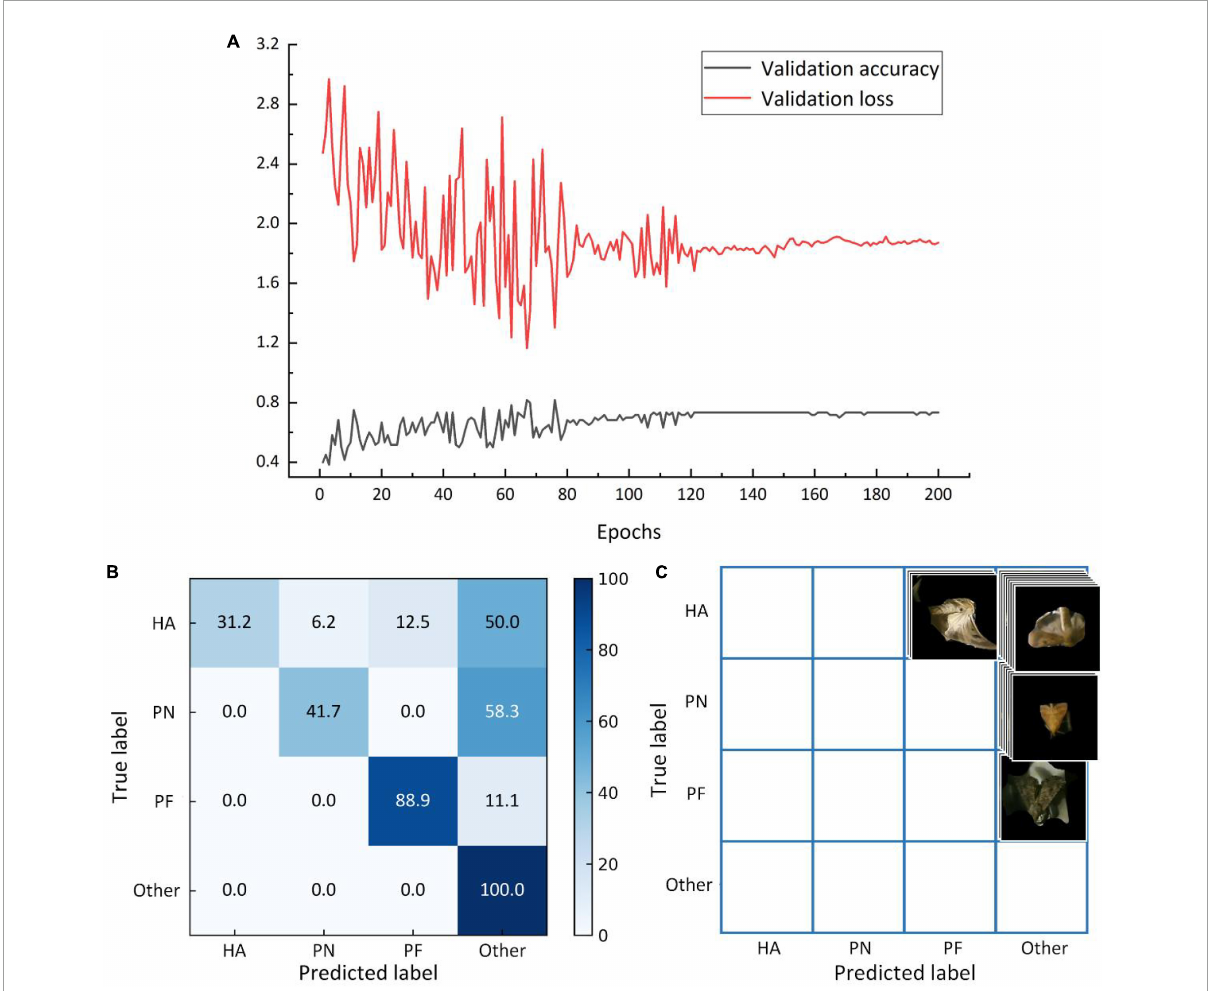
FIGURE10 The average identification accuracy and error curves based on the validation set (A) , matrix of the average identification accuracy based on the test set (B) , and matrix of the misclassified images based on the test set (C) for the model trained on the filling mixed